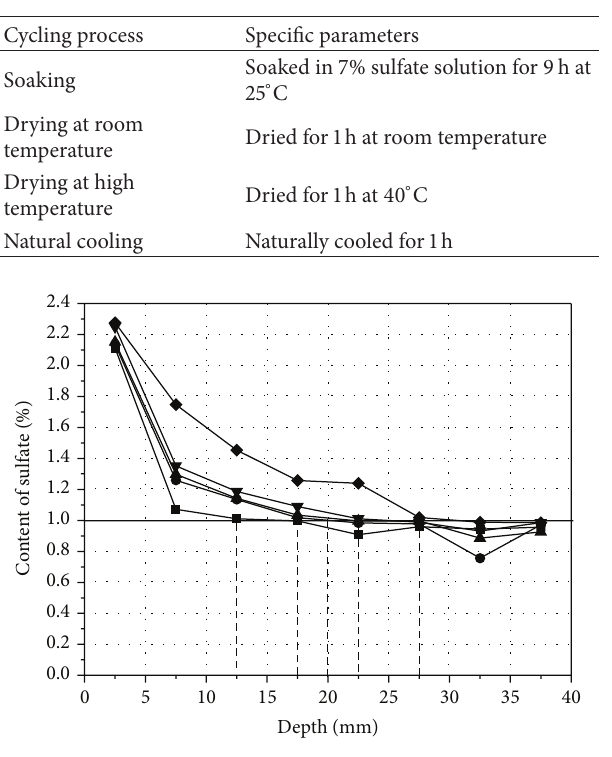
Table 1: Mineral constituents and contents of cement.